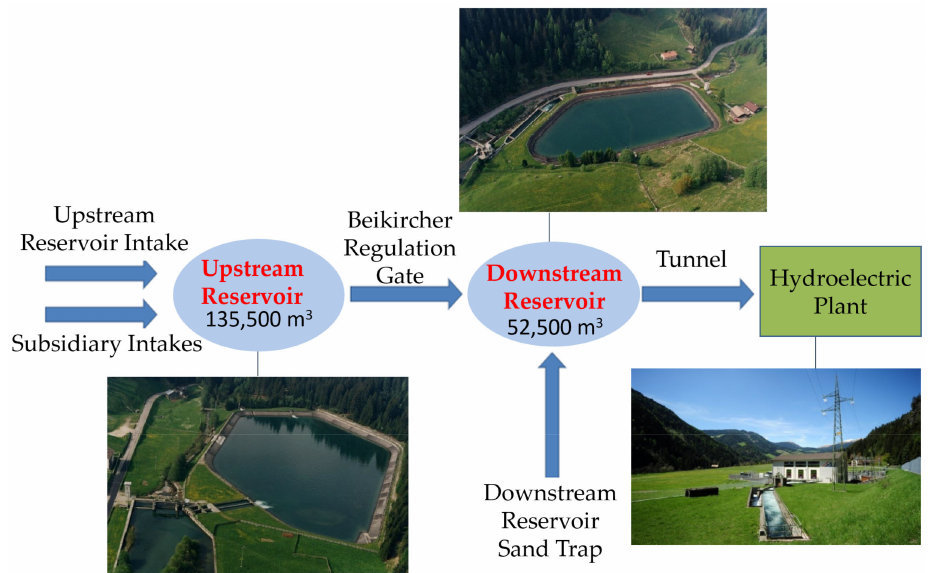
Figure 3. Schematic representation of the